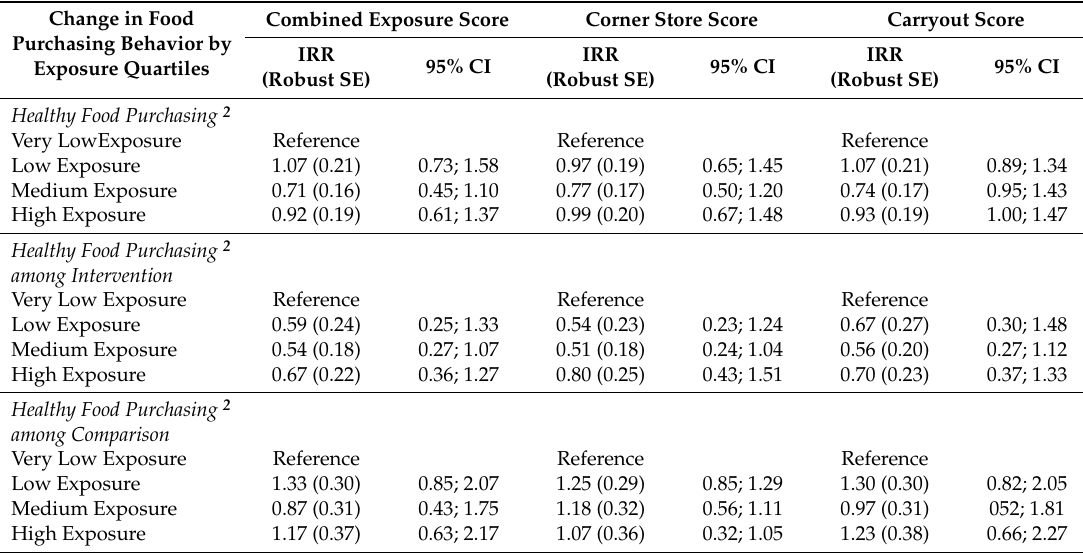
Table 4. Change in healthy food purchasing behavior over time by quartile of exposure level among BHCK caregivers ( n = 387).